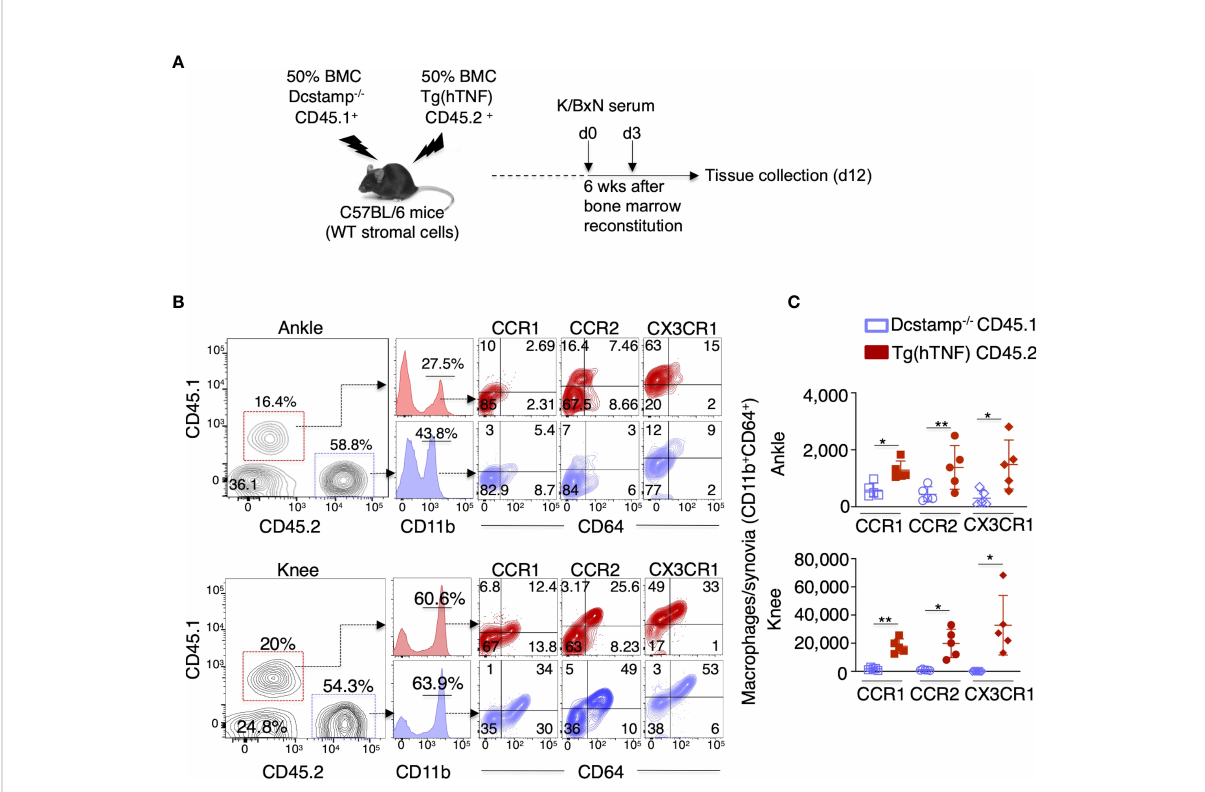
FIGURE 5 Dcstamp -/- macrophages demonstrate impaired cell migration and decreased expression of chemokine receptors. (A) 7-week-old C57BL6 female mice were bone marrow reconstituted with 1x10 7 CD45.1 Dcstamp -/- and 1x10 7 CD45.2 Tg(hTNF) bone marrow cells from 8-week-old mice. Six weeks after bone marrow transplant, mice were injected at days 0 and 3 with serum collected from 8-week-old K/BxN mice and sacri fi ced 12 days after second serum injection. Cell suspensions isolated from synovium were stained with CD45.1, CD45.2, CD11b, CD64, CCR1, CCR2 and CX3R1 antibodies. Graphs show the mean ± SD of CD45.1 or CD45.2 cell frequency (B) and number of CCR1, CCR2 and CX3CR1 expressing macrophages (C) . n = 5 mice/group. * p < 0.05, ** p ≤ 0.005 (Two-way ANOVA and paired Student ’ s